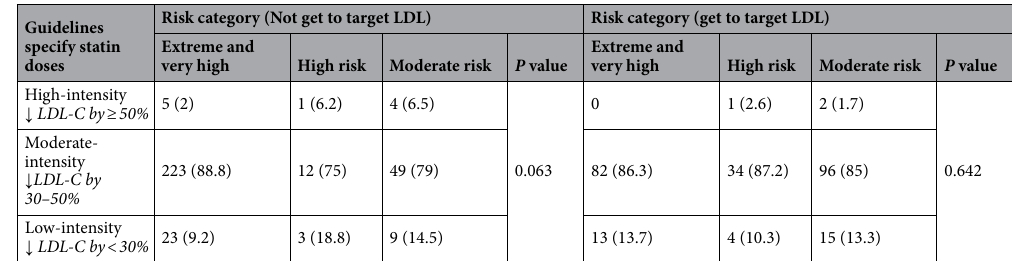
Extreme and very high High risk Moderate risk P value